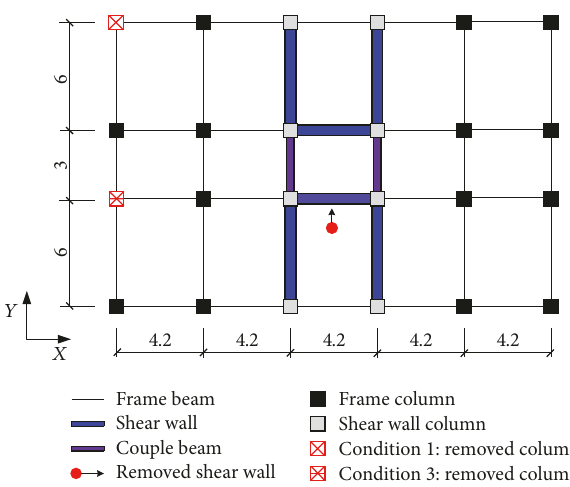
Figure 1: Floor plan of the building models (unit: